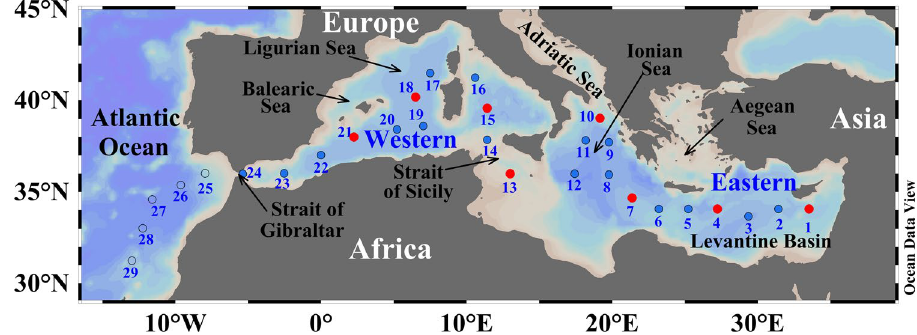
Figure 1. Study area and sampling stations. The circles depict all the cruise stations. Red circles represent the stations where samples were taken for the molecular characterization of DOM. Red and blue circles represent the stations where samples were collected for DOM fluorescence and absorption characterization. Figure created using Ocean Data View (version 4.7.8, R. Schlitzer, 2016.